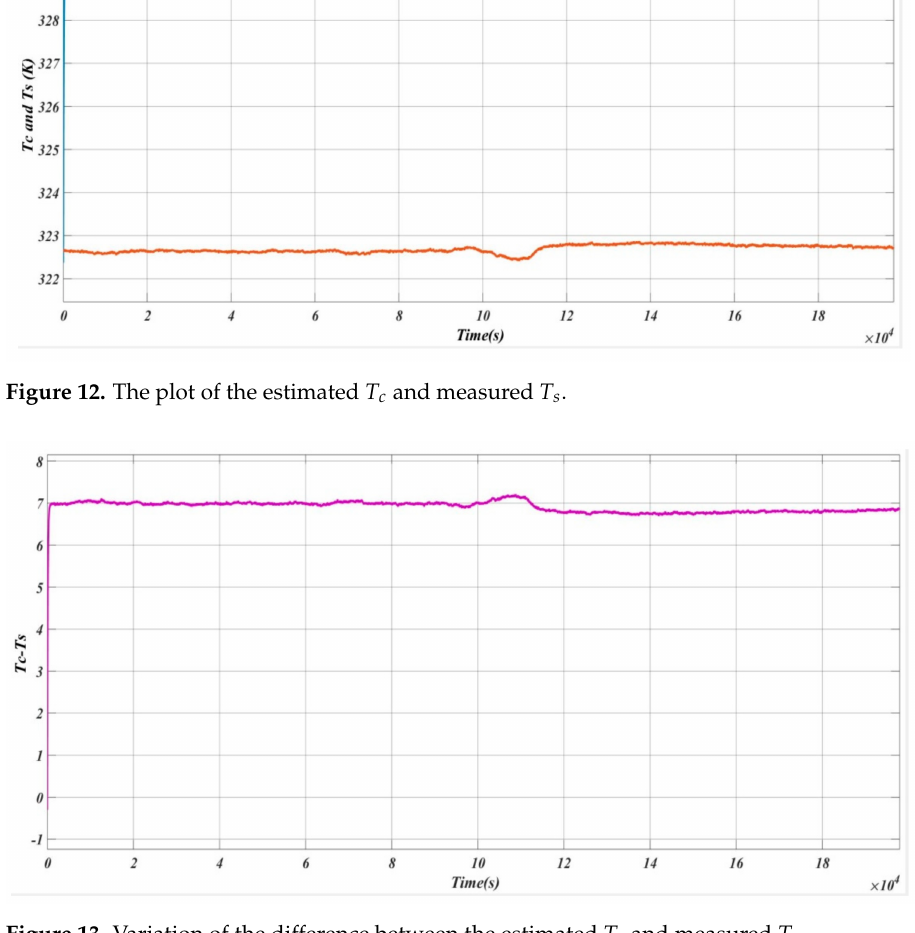
Figure 13. Variation of the difference between the estimated T c and measured T s